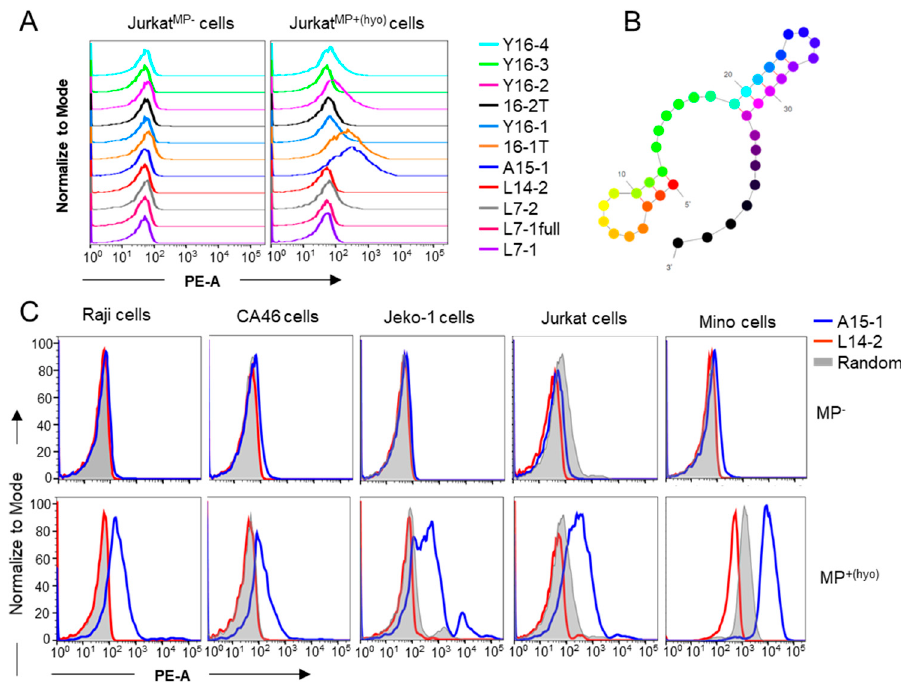
Figure 1. Detection of M. hyorhinis infection by flow cytometry assay. PBS-washed cells were incubated with 50 nM of various Cy3-labeled aptamers in 1 × PBS for 10 min and binding ability was analyzed using flow cytometry. ( A ) Binding tests of the di ff erent aptamers with MP − and MP + (hyo) Jurkat cells; ( B ) predicted secondary structure of L14-2 aptamer; and ( C ) binding tests of A15-1, L14-2, and random library oligos with various MP − and MP + cells. MP − , mycoplasma negative; MP + (hyo) , M. hyorhinis positive. Data show the representative results from three independent experiments.